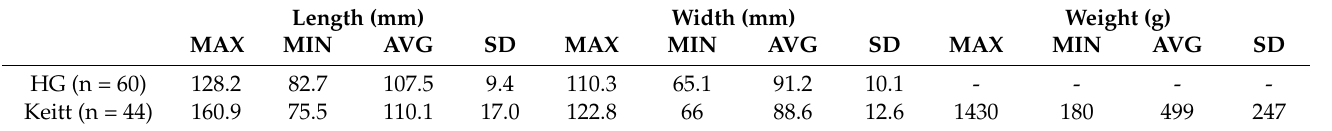
Table 3. Fruit lineal dimensions as assessed using calipers, for two populations of fruit. Length